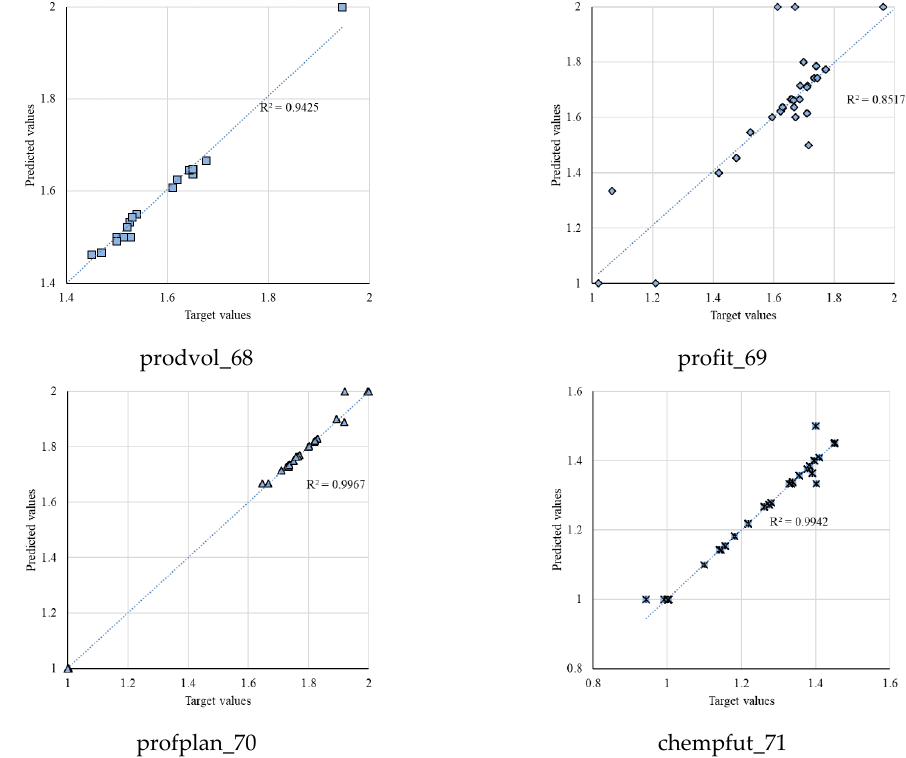
Figure 11. Plot diagrams for the effects of the external environment on output values of firm per- formance.